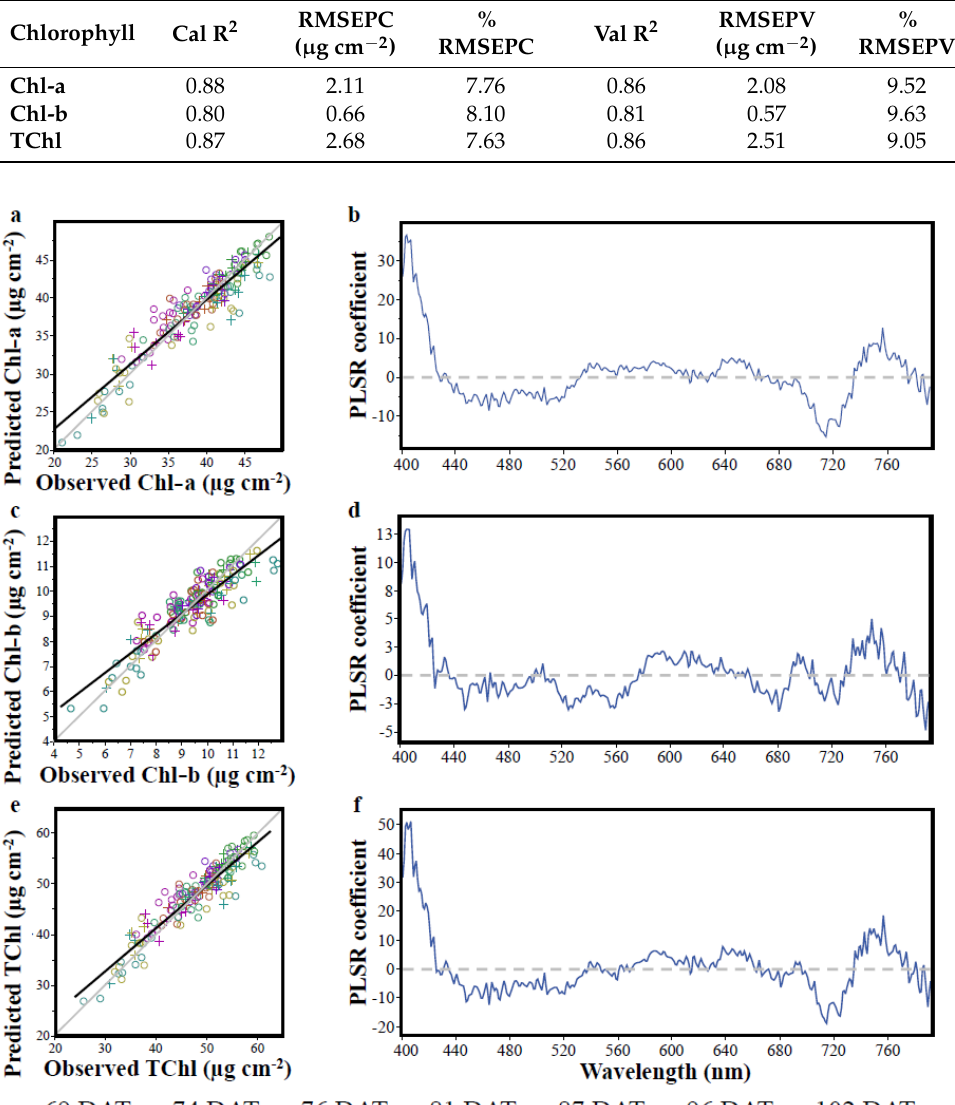
Figure 5. Chl-a, Chl-b, and TChl content estimation by partial least squares (PLSR) models. Observed vs. predicted chlorophyll values ( a , c , e ). Solid black lines are calibration (Cal) best-fit lines and 1:1 lines are gray. Circle and Plus markers represent Cal and Val samples, respectively. The PLSR coefficients for each of the models ( b , d , f ), solid blue lines are coefficient values and dashed gray lines are the zero-coefficient value. Chl-a ( a , b ), Chl-b ( c , d ), and TChl ( e , f ). Table 2. The Chl-a, Chl-b, and TChl estimation based on PLSR model.